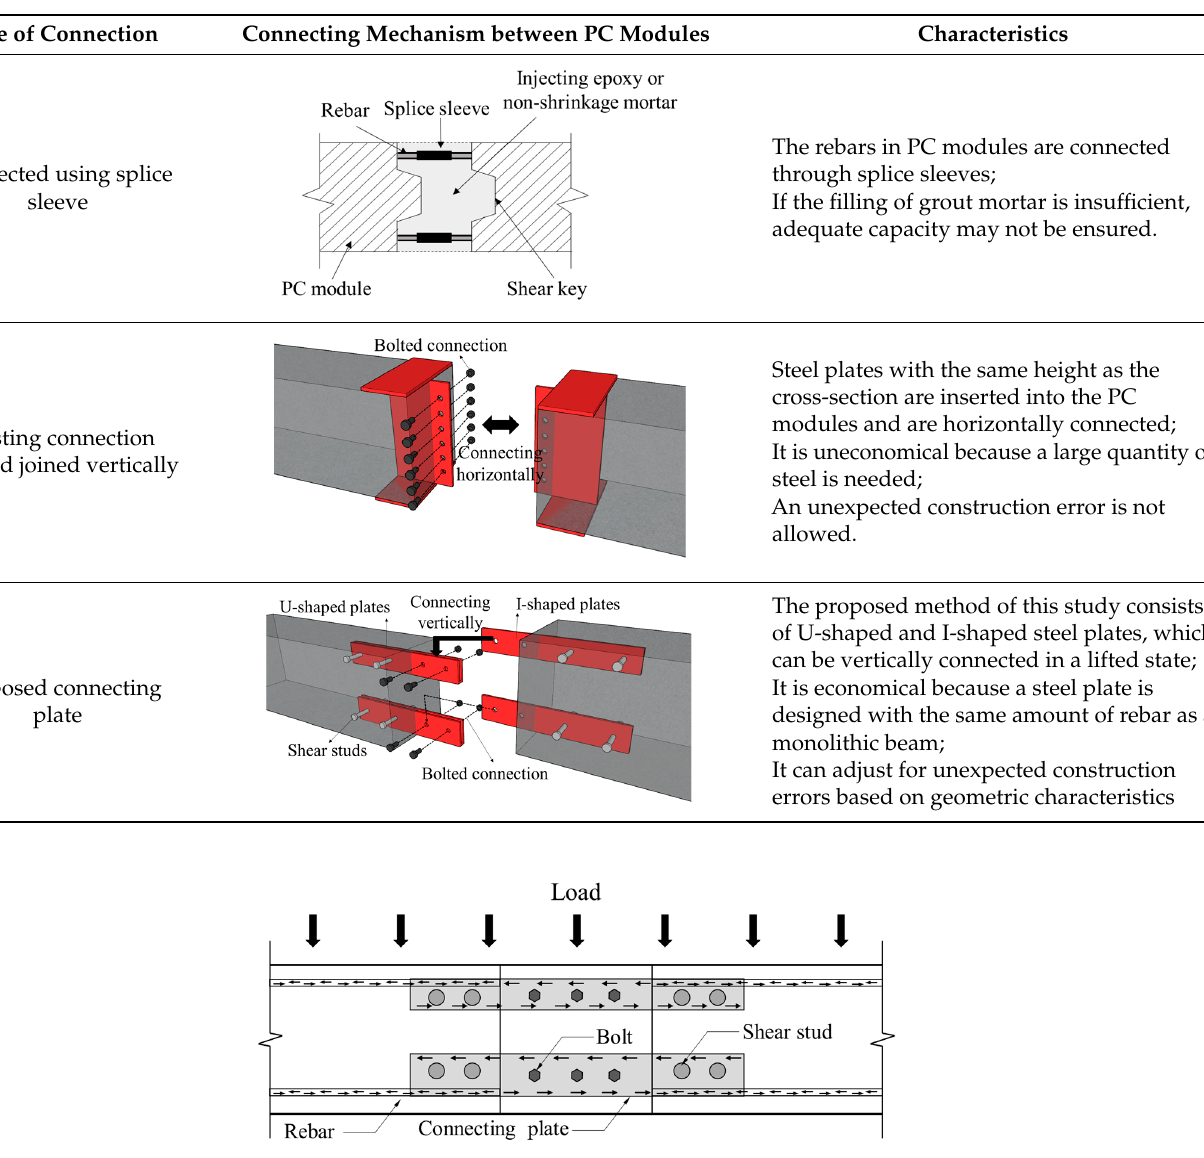
Table 1. Comparison between the existing type of connection and the proposed method.